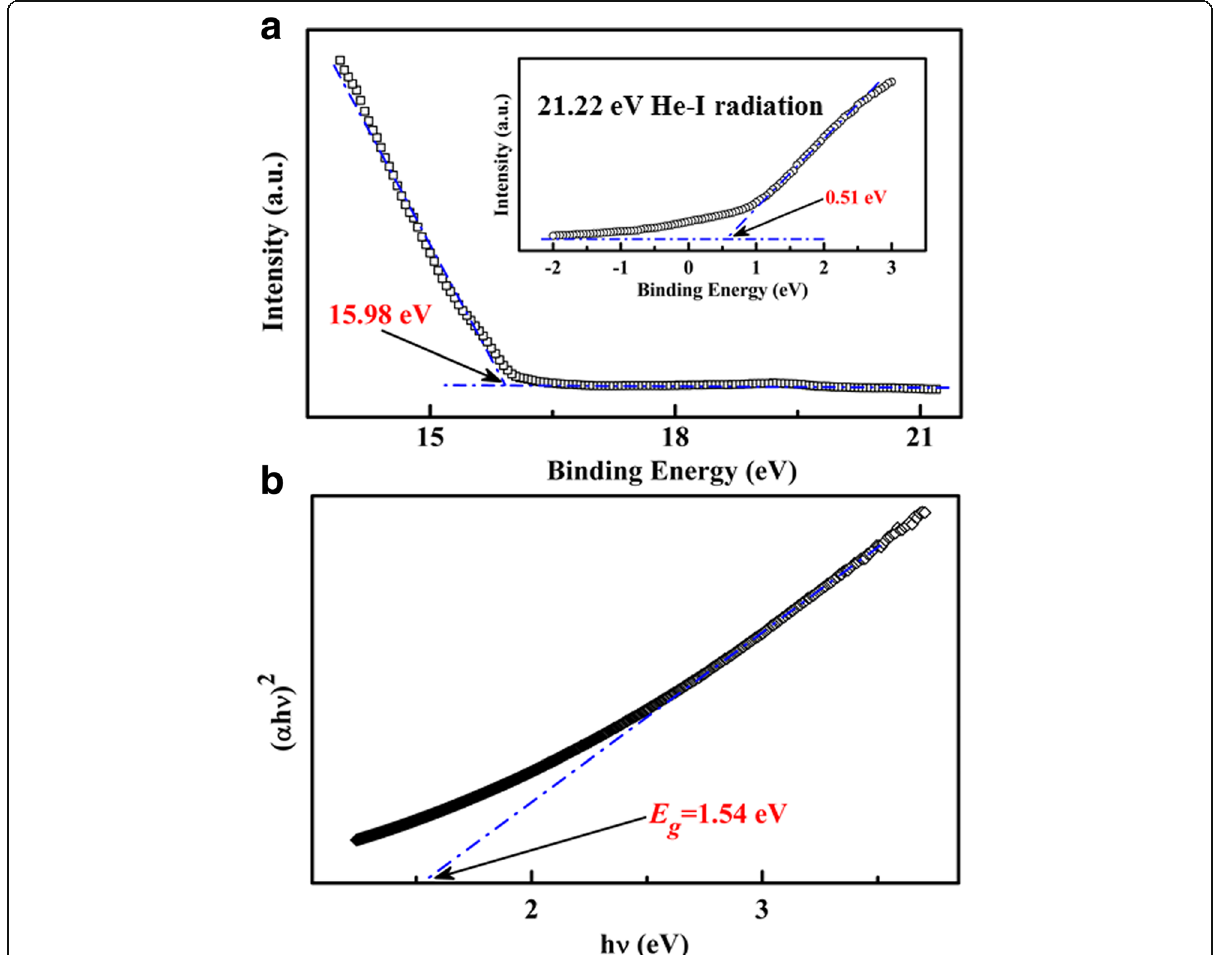
Fig. 6 a UPS spectra of the MoS 2 film on GaAs, showing the Fermi level of the films and the distance between the Fermi level and the top edge of the conduction band. b ( α h ν ) 2 ~ h ν curve from UV spectrum of the MoS 2 film on quartz substrate under the same deposition